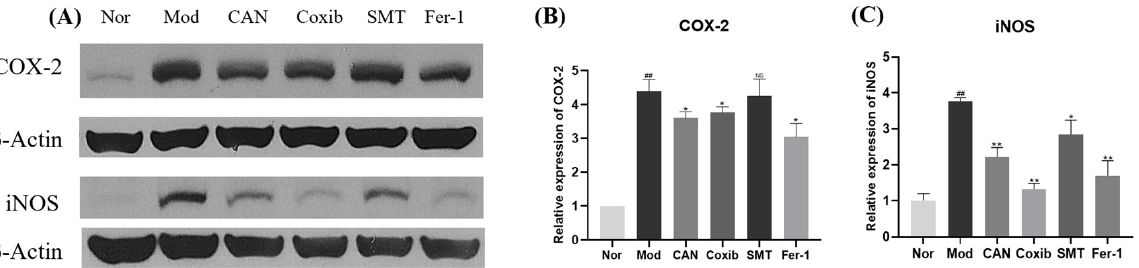
Figure 5. Canagliflozin regulates ferroptosis-mediated inflammatory damage. HL-1 cells were stimulated with 0.1 mM PA for 24 h in the presence or absence of CAN (5 μ g/mL), and the whole cell lysates from HL-1 cells were used for Western blotting analysis. Coxib (5 μ g/mL), SMT (10 μ M), and Fer-1 (5 μ M) were used to explore the relationship between ferroptosis and inflammatory damage. ( A – C ) Effects of CAN, coxib, SMT, and Fer-1 on the levels of COX-2 and iNOS proteins in HL-1 cells. Nor, normal control group; Mod, untreated PA control group; CAN, CAN-treated PA group; Coxib, coxib-treated PA group; SMT, SMT-treated PA group; Fer-1, Fer-1-treated PA group. Data were expressed as mean ± SD ( n = 3). Differences were considered significant at p < 0.05 and highly significant at p < 0.01 (## p < 0.01 vs. Nor; * p < 0.05, ** p < 0.01 vs. Mod). 2.6. Canagliflozin Promotes AMPK Activation through Upregulating LKB1, TAK1, and p-CaMKK2 Next, we investigated the mechanism of CAN inhibiting PA-induced inflammation and ferroptosis. Energy metabolism is abnormal in DCM. AMPK, as an important kinase regulating energy homeostasis, also plays a key role in DCM [3]. LKB1, TAK1, and CaMKK2 are key factors regulating AMPK. Through Western blotting analysis, we found that PA significantly downregulated the protein levels of LKB1 and TAK1 as well as the phosphorylation of CaMKK2 and AMPK, while CAN activated AMPK by upregulating LKB1, TAK1, and p-CaMKK2 (Figure 6A–G). Figure 6. Canagliflozin promotes AMPK activation through upregulating LKB1, TAK1, and p- CaMKK2. HL-1 cells were stimulated with 0.1 mM PA for 24 h in the presence or absence of CAN (5 μ g/mL), and the whole cell lysates from HL-1 cells were used for Western blotting analysis. ( A – C ) Effects of CAN on LKB1 and TAK1 in HL-1 cells. ( D – G ) Effects of CAN on the ratios of p- CaMKK2/CaMKK2 and p-AMPK/AMPK in HL-1 cells. Nor, normal control group; Mod, untreated PA control group; CAN, CAN-treated PA group. Data were expressed as mean ± SD ( n = 3).